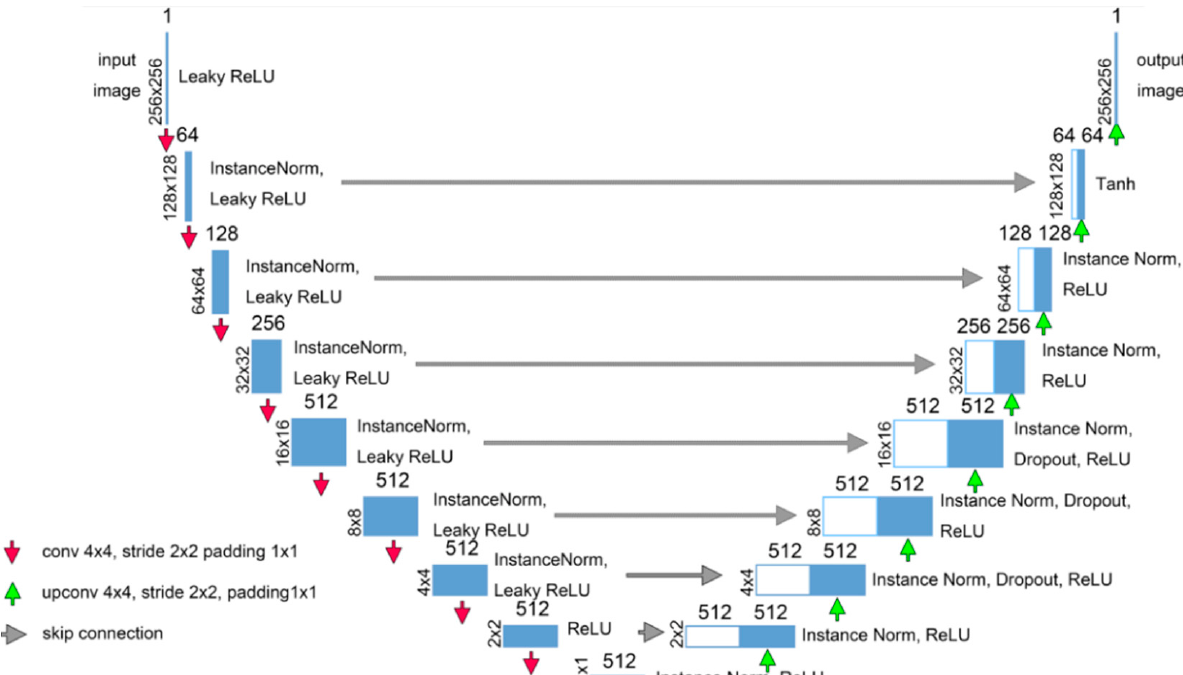
Figure 2. The architecture of the U-net generator. U-net is named for its U-shaped network architec- ture, and it is an end-to-end encoder–decoder model for semantic segmentation. We followed the U-net configuration in the pix2pix GAN. The network has 16 layers, with an 8-layer encoder and an 8-layer decoder. See the text for detailed information.